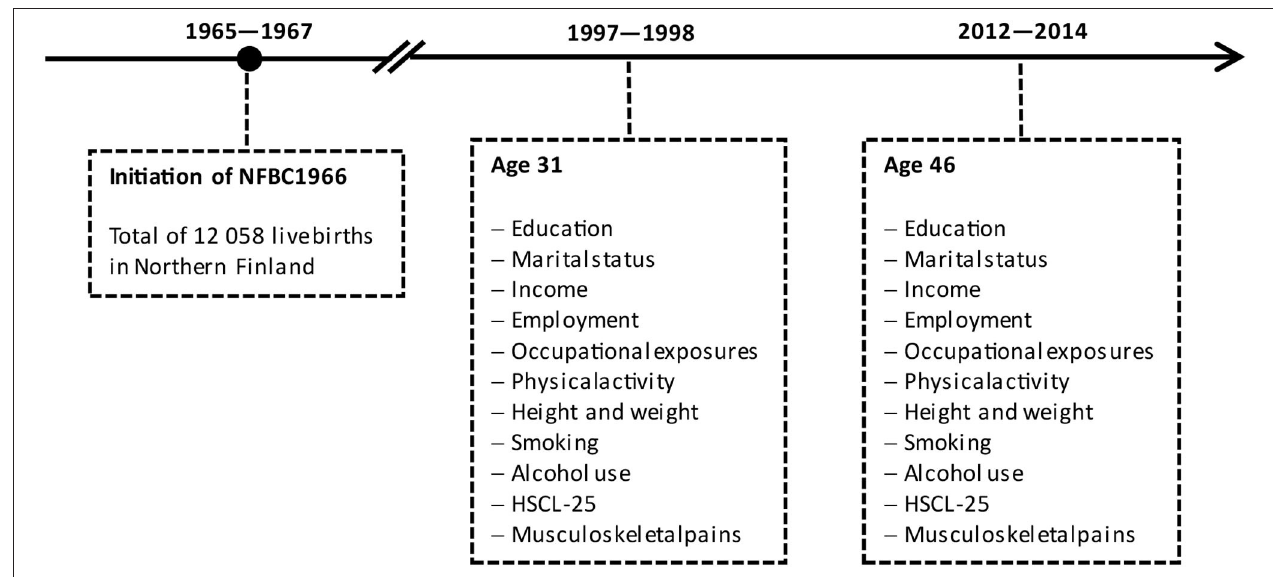
FIGURE 1 | Flow chart of the study. HSCL-25, Hopkins Symptom Checklist-25; NFBC1966, Nothern Finland Birth Cohort 1966.